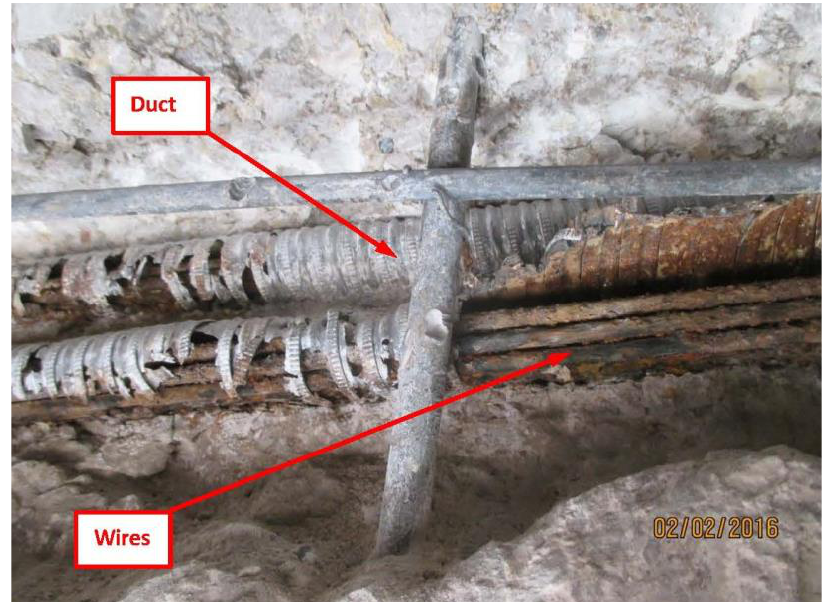
Figure 3. Detail of sampling spot of corroded wires.